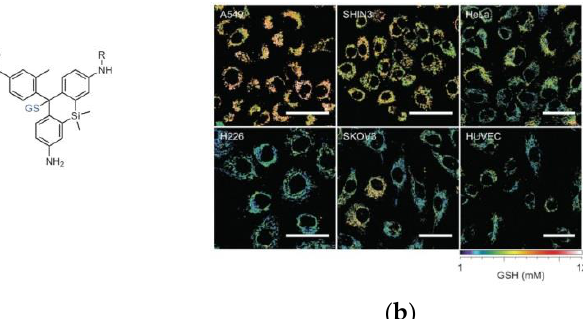
Figure 19. ( a ) Mechanism of QuicGSH activation by GSH; ( b ) Quantification of GSH in several cell lines. Reproduced with permission from [86]. Copyright 2016 Nature.